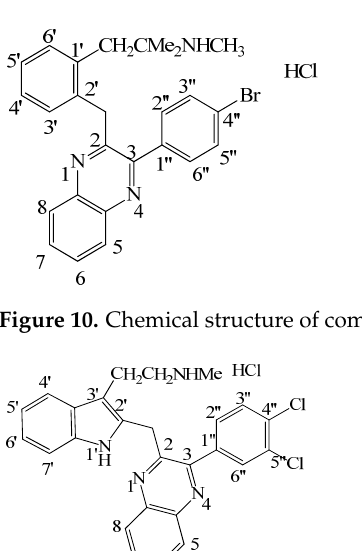
Figure 9. Chemical structure of compound 2f .